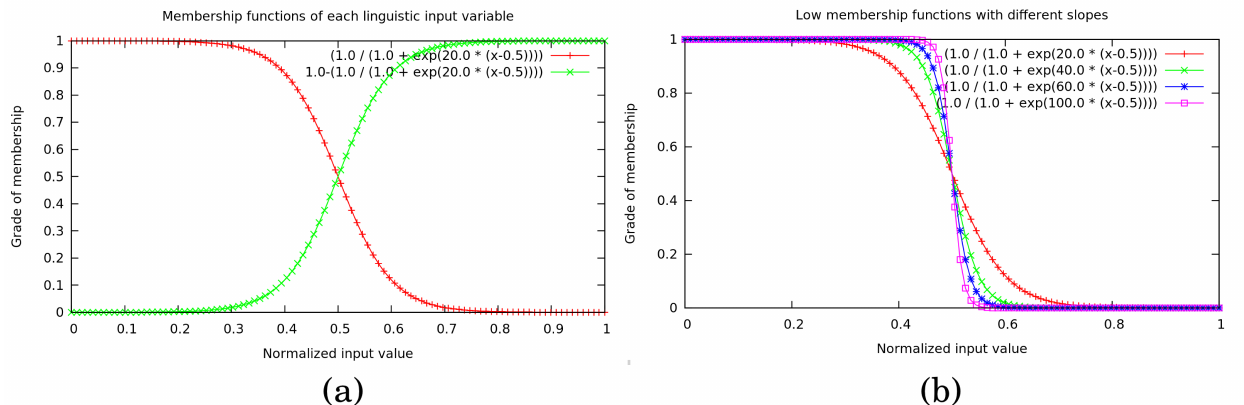
Figure 4. Membership functions of each linguistic input variable ( a ). Low membership functions with different slopes ( b